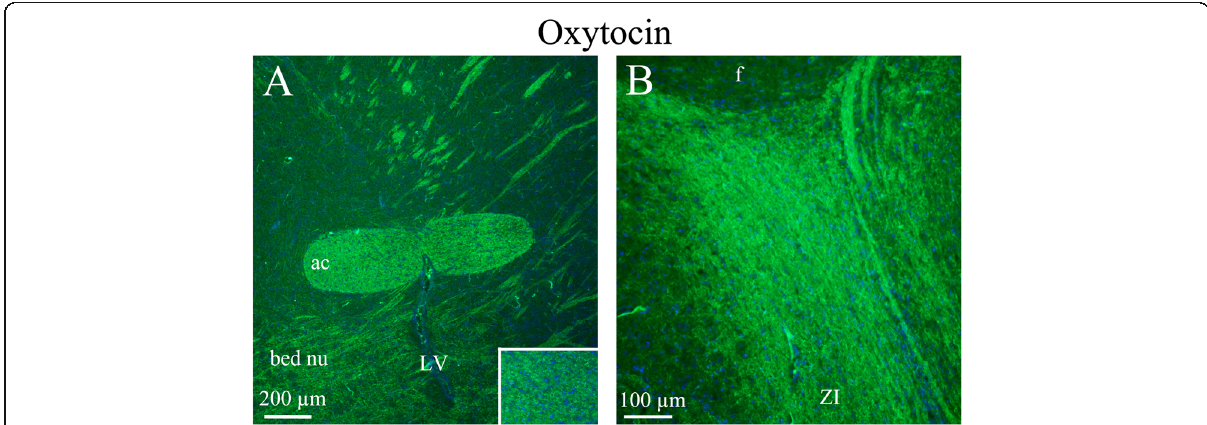
Fig. 7 Oxytocin immunohistochemistry of the anterior commissure, bed nucleus and zona incerta. a . The white matter tract anterior commissure (ac) showed distinct fiber oxytocin immunoreactivity in fibers (Insert: higher magnification of ac). In addition, fibers in the bed nucleus also expressed oxytocin. b The zona incerta displayed intense oxytocin immunoreactivity in thin fibers